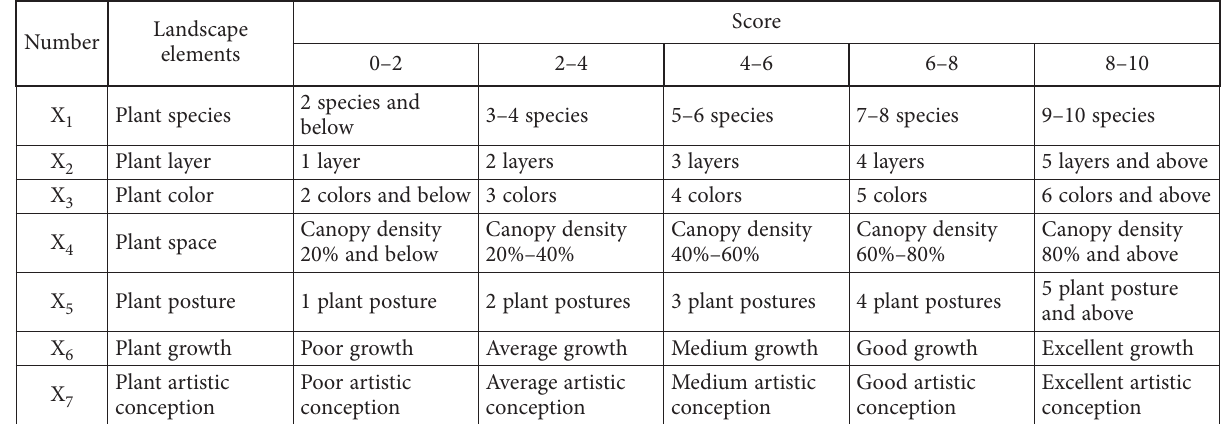
Table 1. Evaluation criteria of landscape